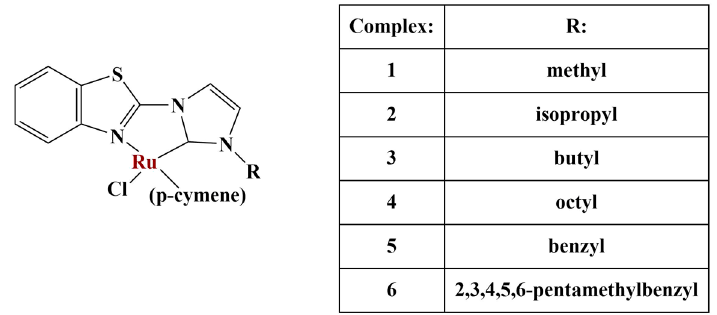
Figure 13. The complexes presented in [58].